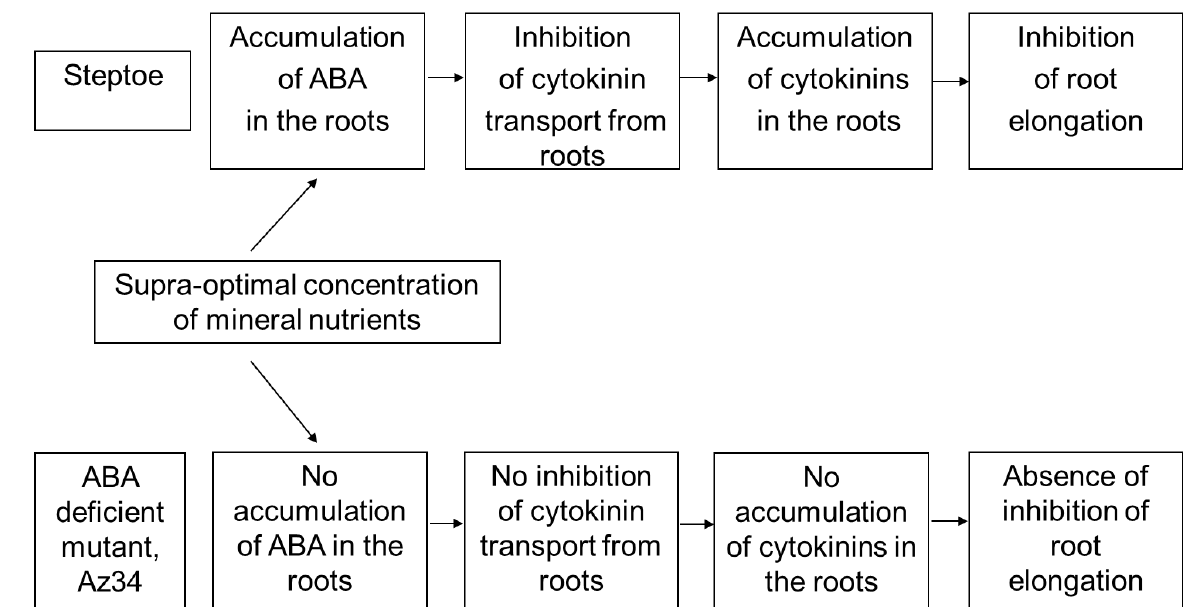
Figure 8. Responses of ABA-deficient barley mutant (Az34) and its parental genotype Steptoe to supra-optimal concentration of mineral nutrients.